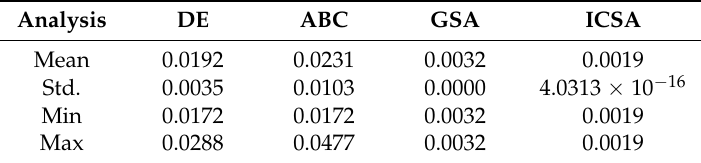
Table 6. Results of exact circuit model Cos t EM for motor 1.